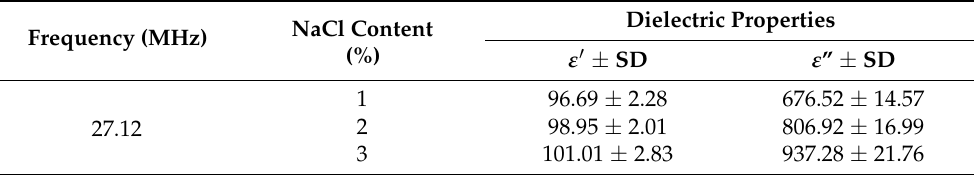
Table 2. The DPs of samples with different NaCl contents (1%, 2% and 3%) at an RF frequency of 27.12 MHz and a temperature of 25 ◦